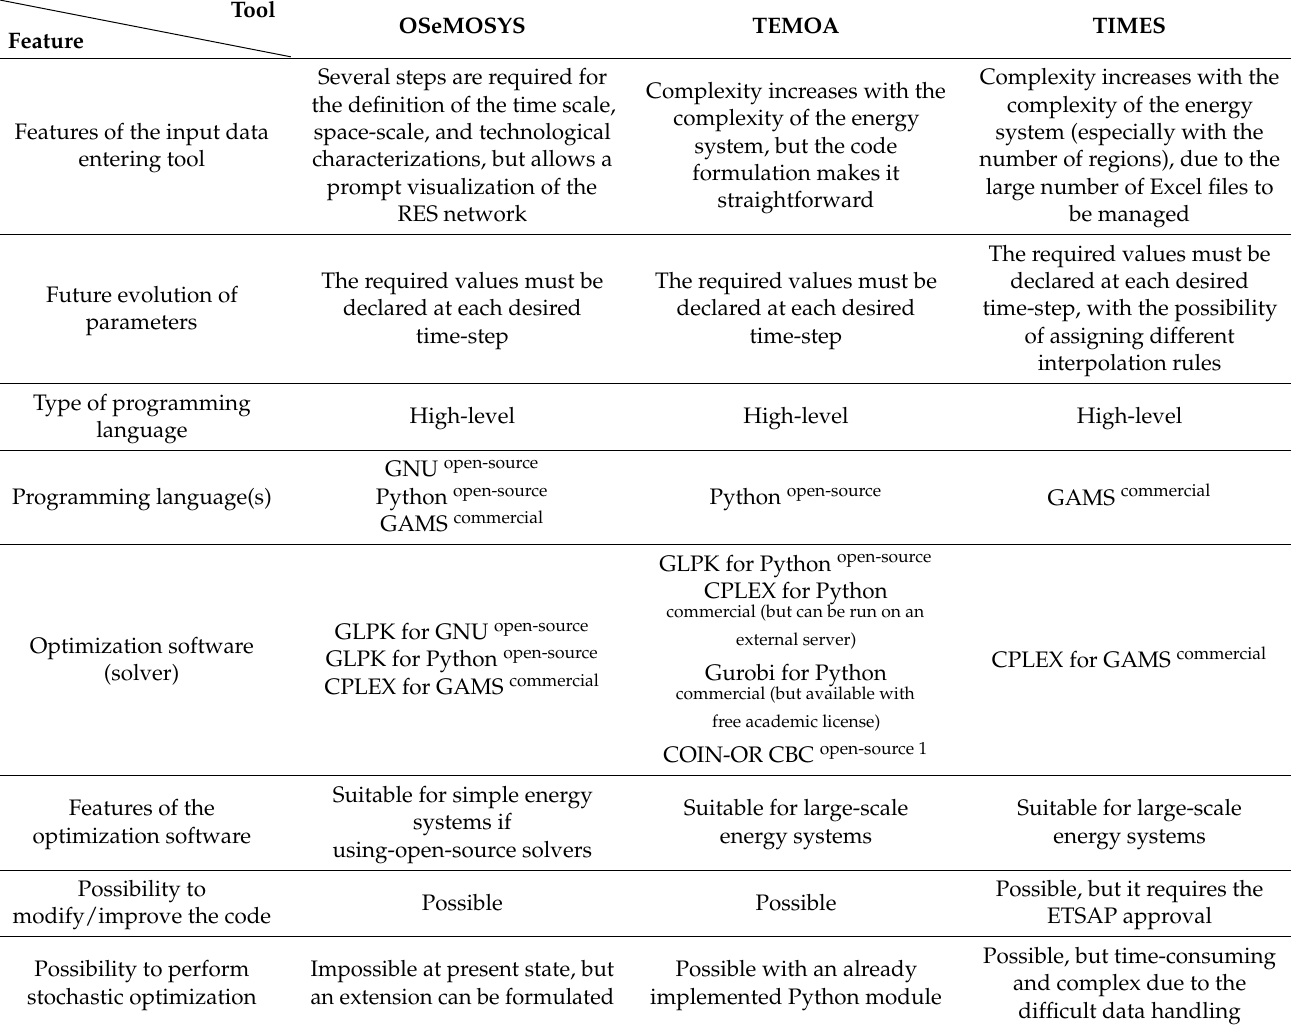
Table 1. Comparison of available tools for macro-scale energy system